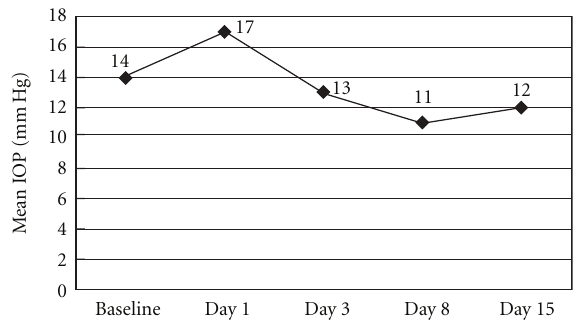
Figure 2: Change in the IOP of the operative eye before and after